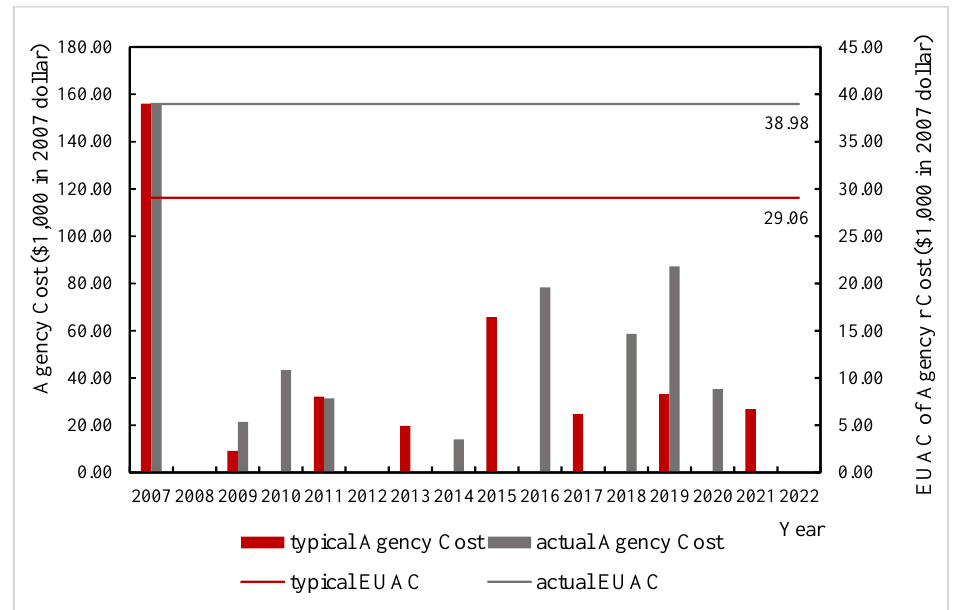
Figure 5. Annual agency costs and discounted EUAC values for the typical and actual activity profiles.